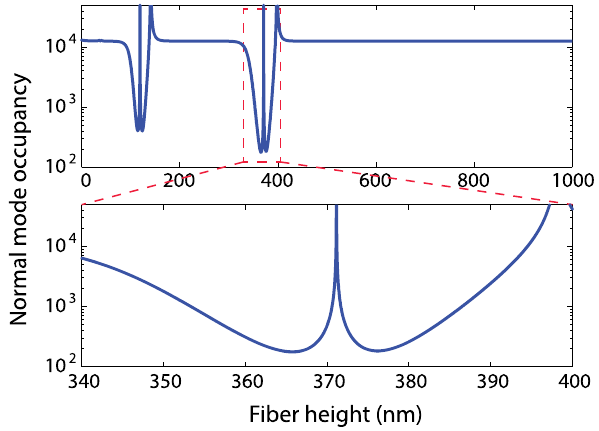
FIG. 10. Predicted achievable phonon number via optomechan- ical cooling of a fiber taper coupled nanobeam incorporated ¼ 0 ). Device parameters are into an oval racetrack resonator ( γ p γ ¼ L ¼ 21 μ m, ω = 2 π ¼ 1 GHz, L = 2 π ¼ 7 . 3 MHz, m ¼ 3 . 1 pg, i c m ¼ 10 6 , 5 K bath temperature. For the oval racetrack cavity, Q m 2 L ¼ 2 L þ 2 π R ¼ 10 μ m is the radius of curvature , where R c c c of the cavity